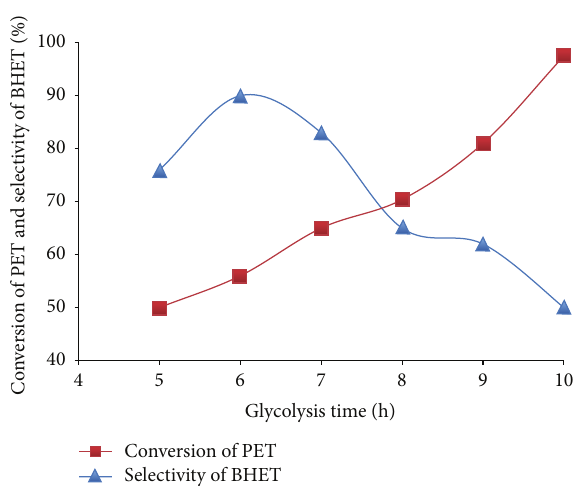
Figure 4: Effects of glycolysis time on the conversion of PET and selectivity of BHET (1atm, 180 ∘ C, with 4.0 gr of [bmim] Br) [9].